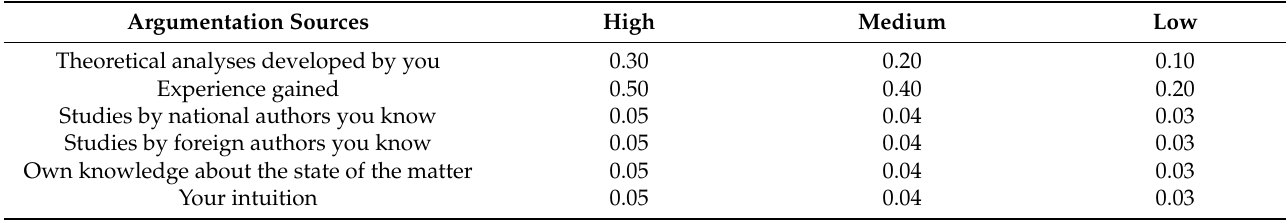
Table 3. Assessment of the sources of reasons to obtain the argumentation coefficient (Ka).